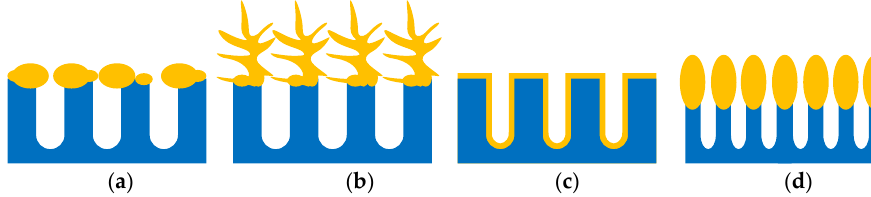
Figure 2. The schematic views of plasmonic structures formed on porous silicon: ( a ) metallic particles and ( b ) metallic dendrites on the outer surface of the porous layer; ( c ) conformal metallic film on the pore walls; ( d ) oval ‐ shaped metallic NPs on the top of the silicon nanowires.